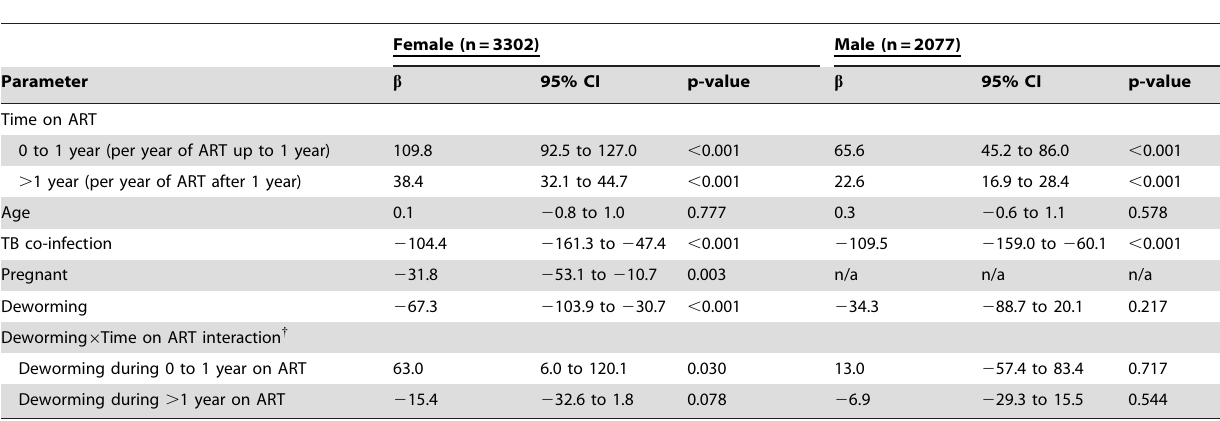
Table 3. Multivariable linear regression model of predictors of CD4 count, stratified by gender (n=5379).